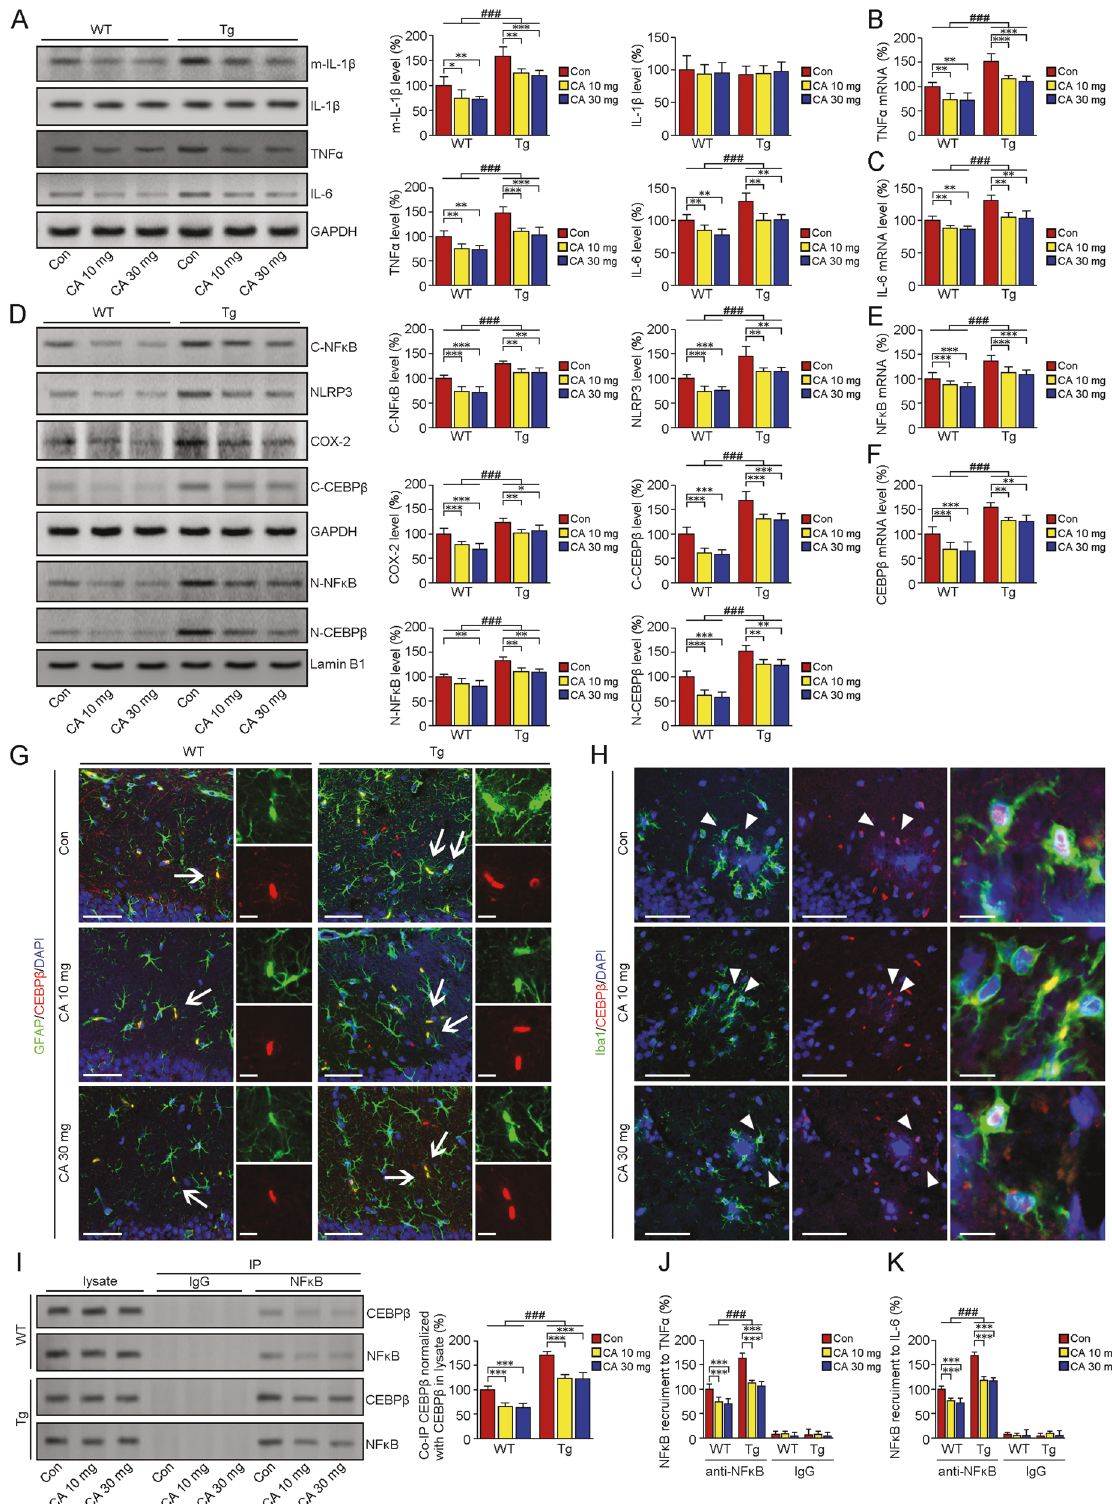
hyperphosphorylated tau are observed in the hippocampus of the mouse model between 12 – 15 months of age. Knockout of CEBP β in this 3×Tg-AD mice could reduce above AD-like pathologies via inhibiting δ -secretase [65]. Interestingly, CEBP β overexpression induced by hippocampal stereotactic injection with Adeno- Cell Death and Disease (2022)